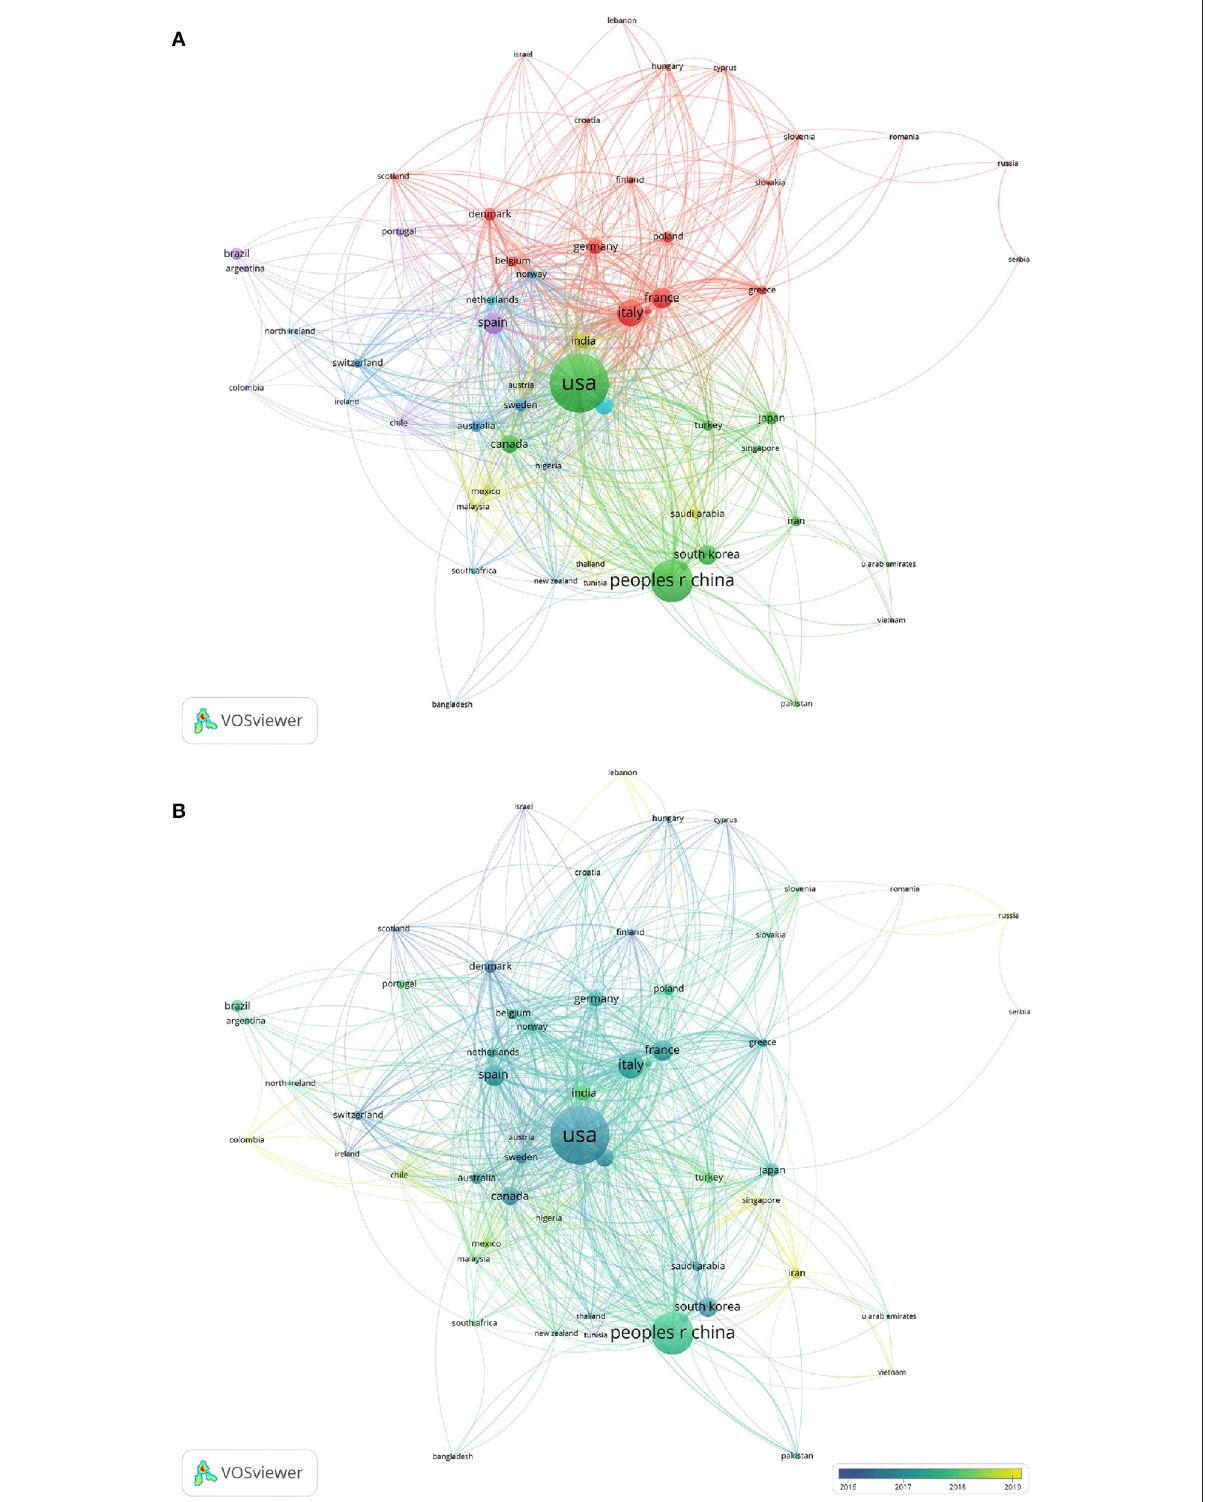
FIGURE4 The network map of co-authorship between countries with more than five publications. (A) The network visualization map of co-authorship between countries with more than five publications. (B) The overlay visualization map of co-authorship between countries with more than five publications. The distance between circles reflects the relationship strength between different countries based on how frequently they occur together. The size of the circle represents their total link